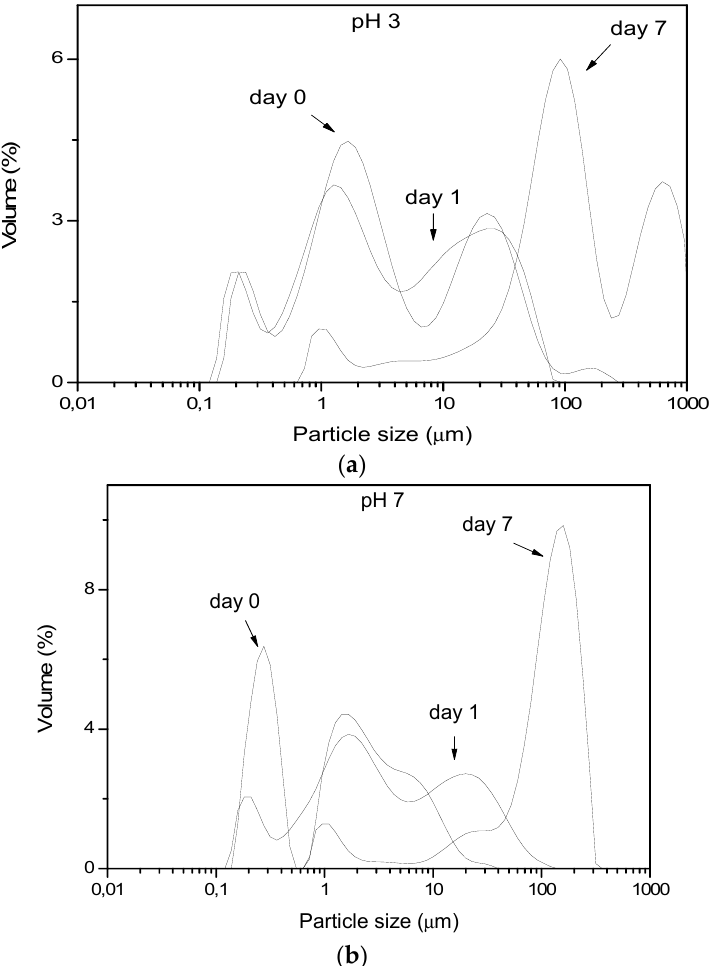
Figure 3. Size distribution of the particles in miglyol-in-water emulsions prepared usingas emulsifier the extract obtained from partially composted olive waste + leaf mixtures extracted at pH 5 (OC5). The emulsions pH is 3 ( a ) and 7 ( b ).